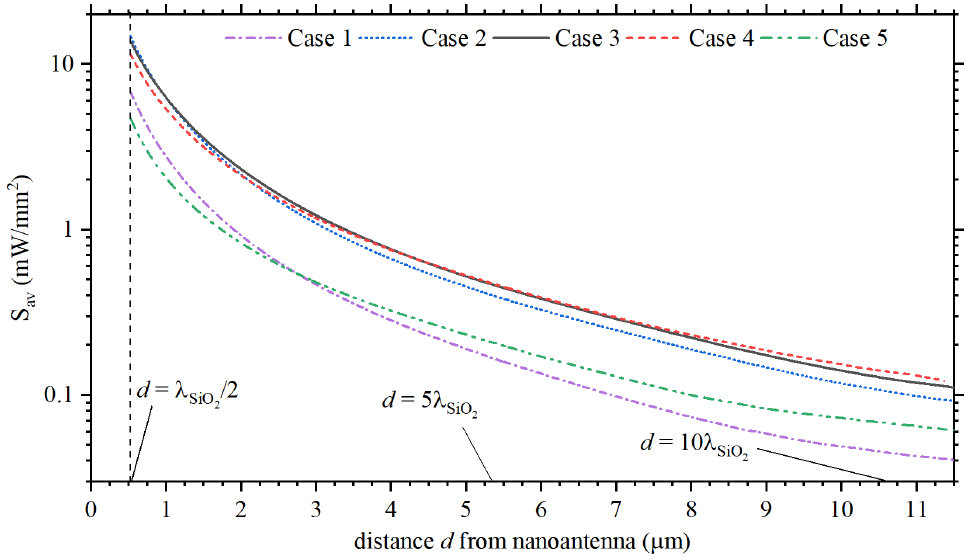
Figure 6. Numerical results for S av = | ( 1/2 ) Re ( E sca × H ∗ sca ) | along the x -axis. Data were collected for d ≥ λ SiO /2, considering d = 0 as the last director for each design. 2